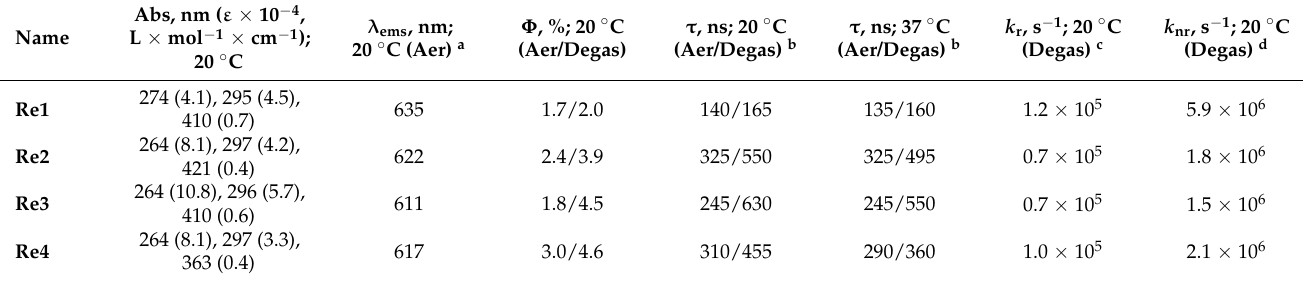
Table 2. Photophysical properties of complexes Re1 – Re4 in